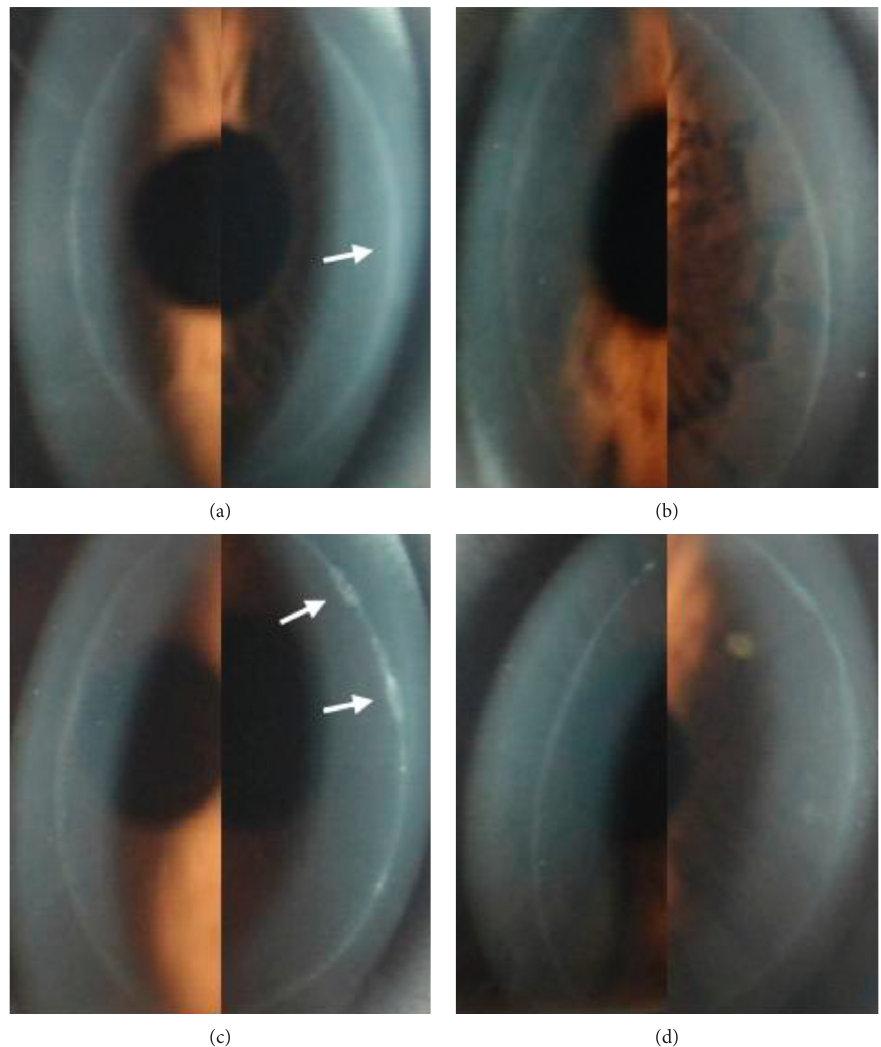
Figure 3: Corneal flap margin and adjacent regions photographed by slit-lamp biomicroscopy at 6 months after surgery. A smooth cir- cumferential band that is slightly wider (white arrow) on the nasal side in the non-BCL-treated right eye (a) and a smooth, narrow cir- cumferential band in the BCL-treated left eye (b) of a patient. A circumferential band with a slightly more reflective focal scar (white arrow) on the nasal side in the non-BCL-treated right eye (c) and a less reflective circumferential band in the BCL-treated left eye (d) of a